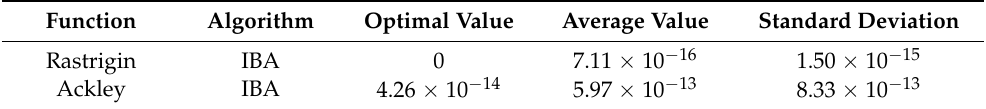
Table 1. Test function